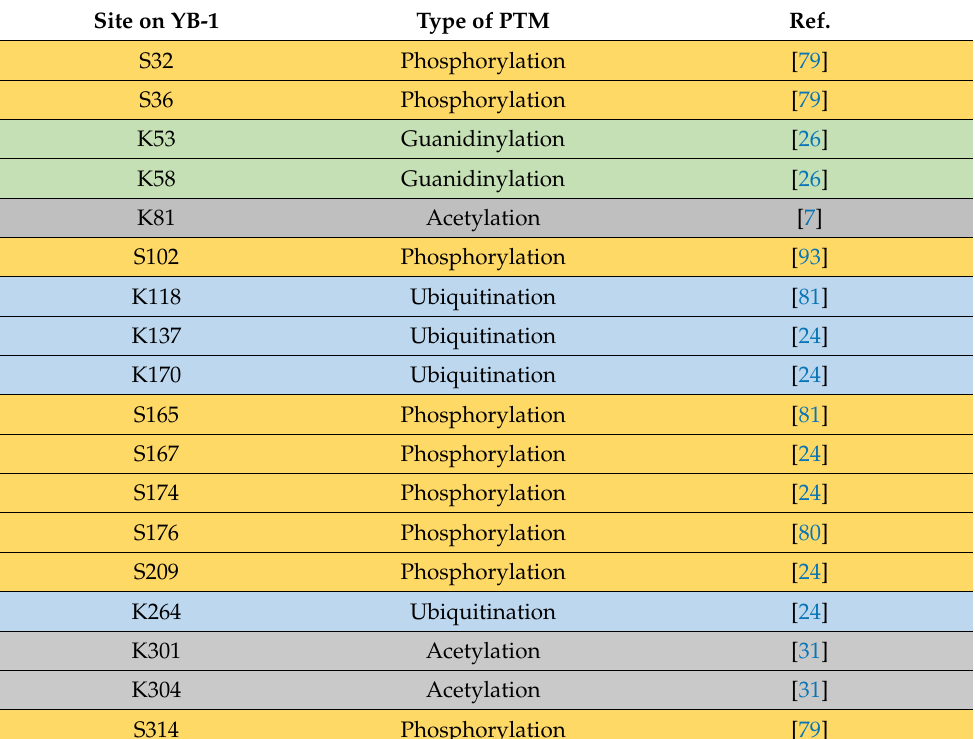
Table A1. The residue, type of modification, and corresponding references to Figure